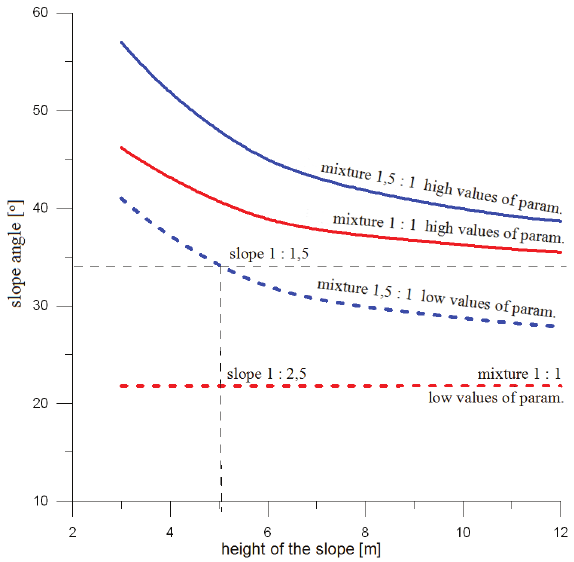
Figure 6: Safe slope gradient of the road embankment formed from ash-sand mixtures in the function of embankment height - results obtained for the factor of safety F = 1.5 [1]. min